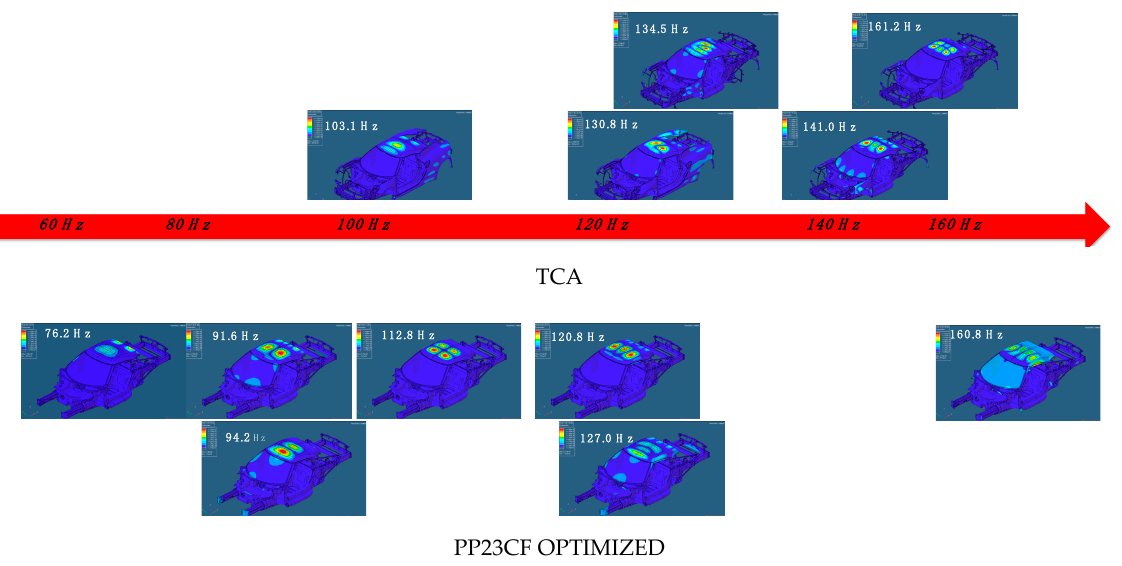
Figure 20. Car roof modal shapes and related eigenfrequencies when considering the two materials, TCA and PP23CF OPTIMIZED, for the pavilion.